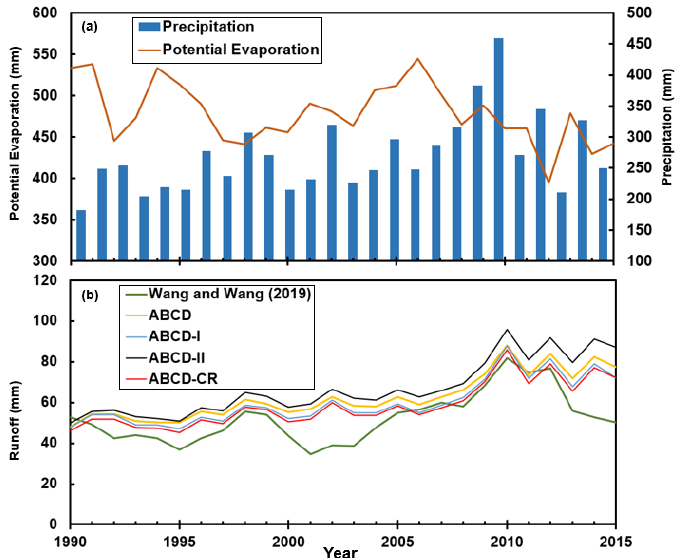
Figure 8. Annual precipitation and potential evaporation ( a ) and the restored annual runoff from different models ( b ).